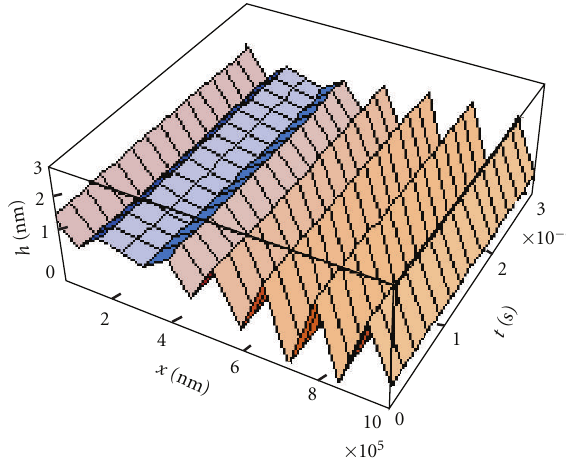
Figure 3: A 3D graph representing time evolution of spines at early stages (linear regime)